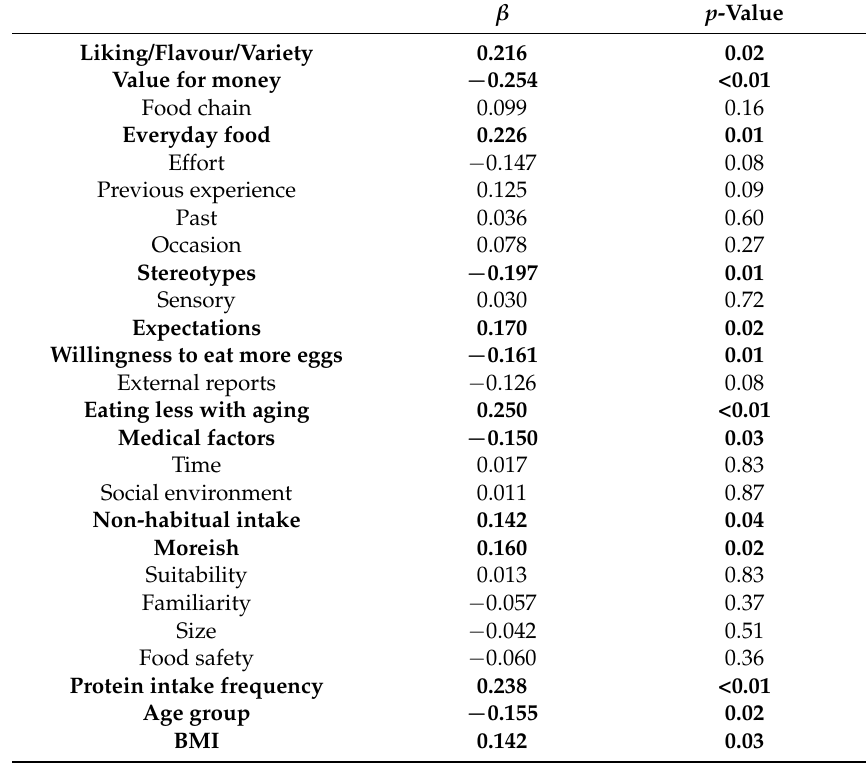
Table 5. Outcomes of the multiple linear regression model assessing the effect of the PCA components, and protein intake, age group and BMI, on egg intake. BMI was imputed with the mean, where necessary. Significant effects are given in bold ( p <